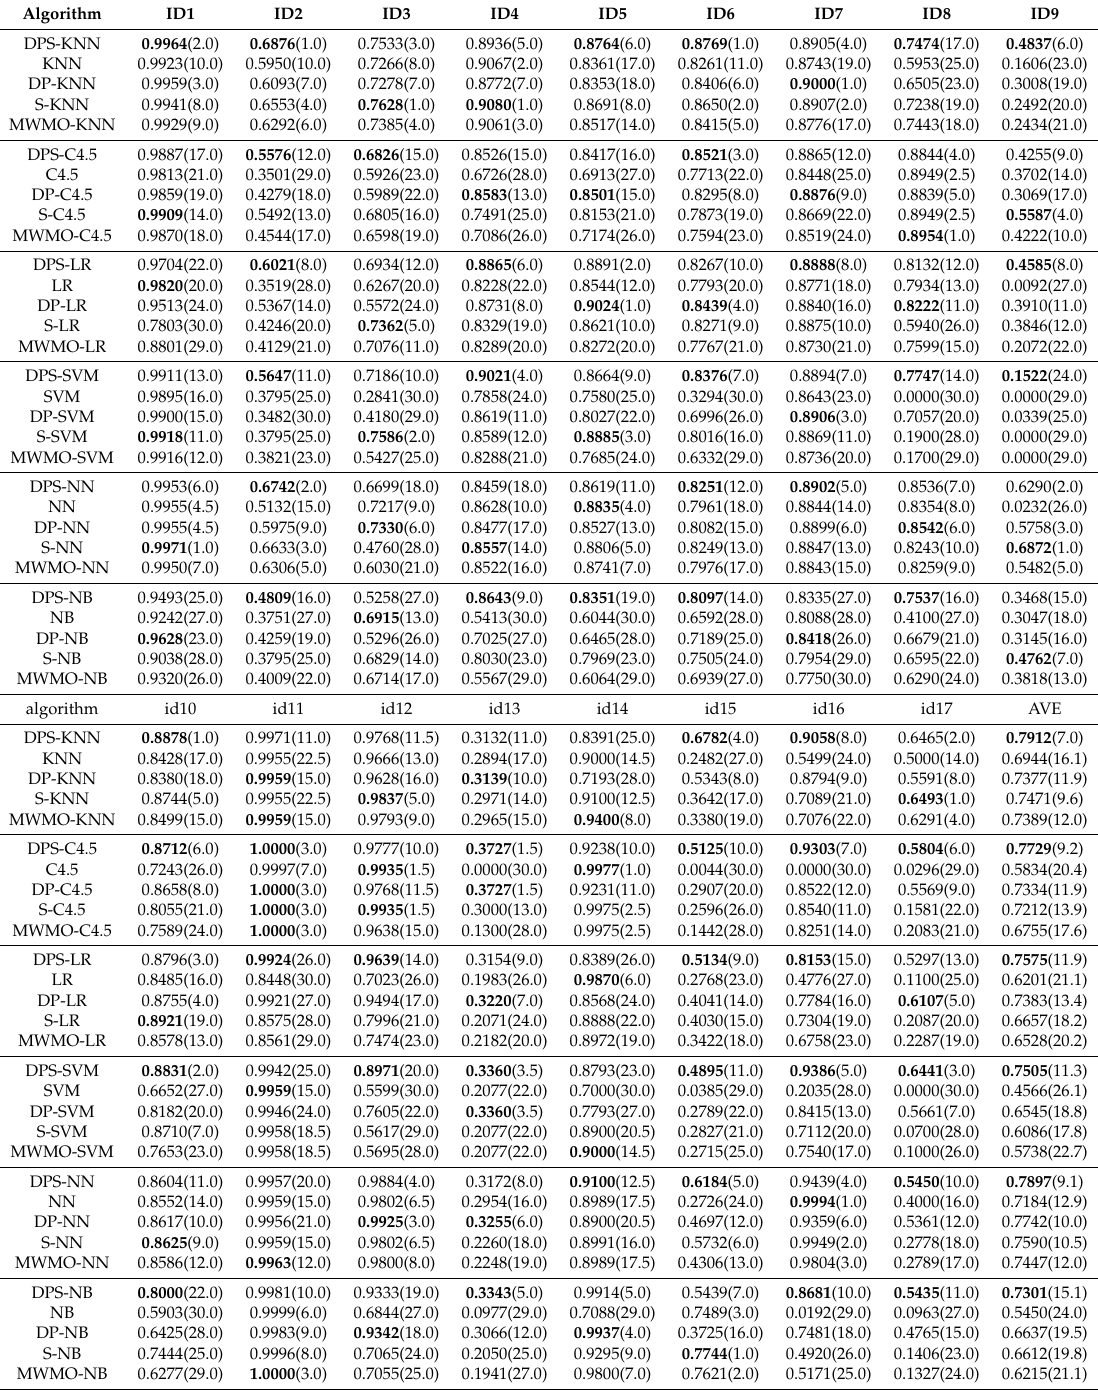
Table 4. Experimental results of models on g-mean